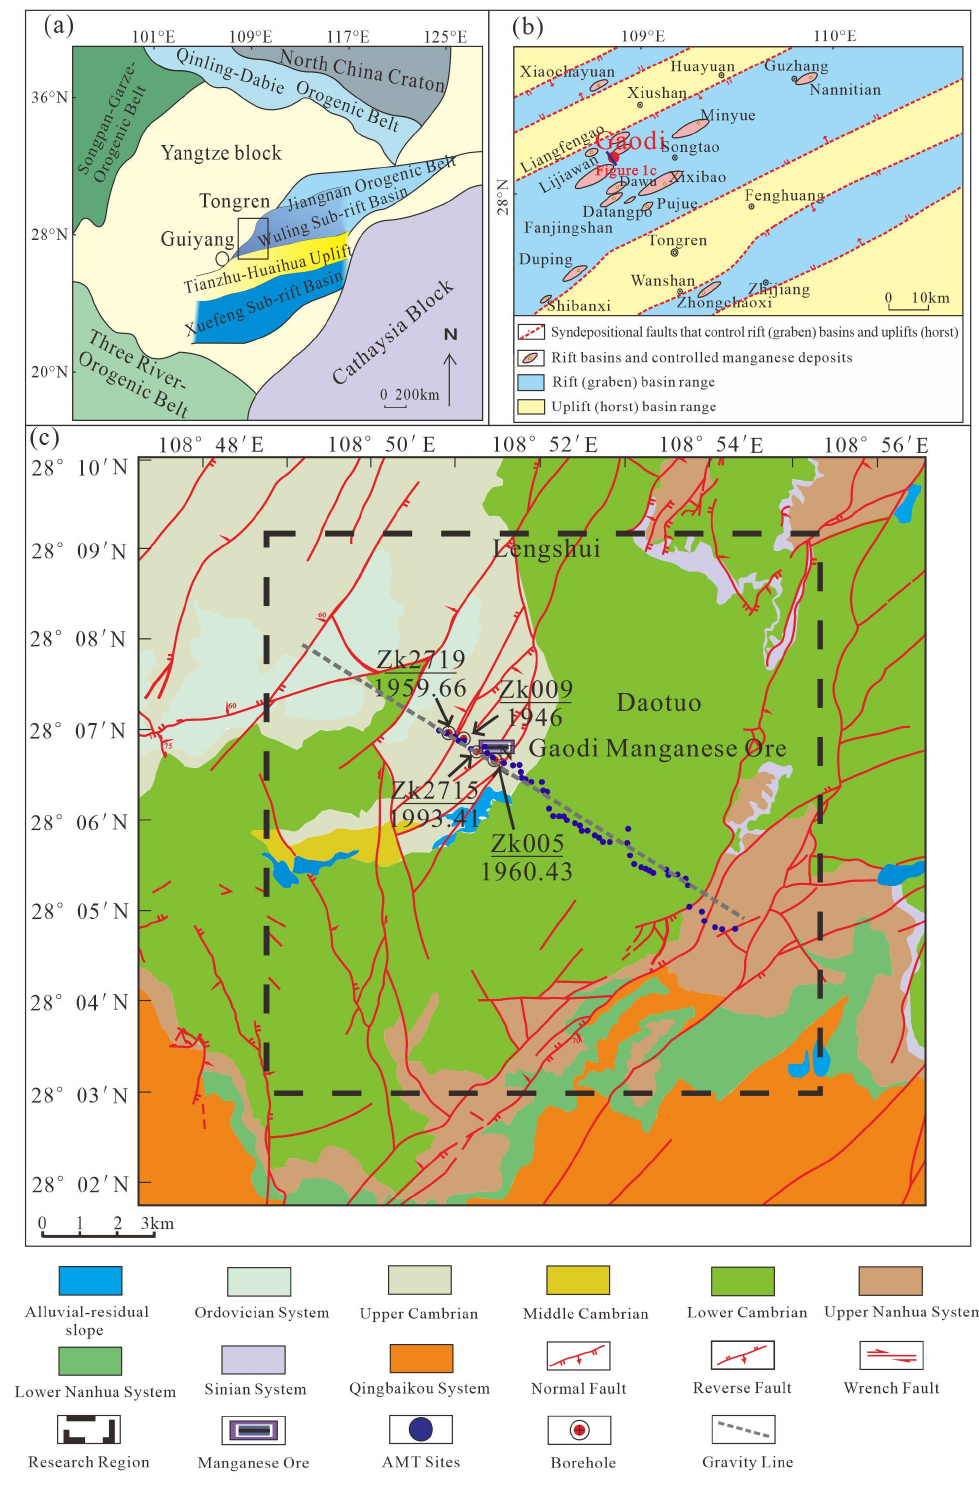
Figure 1. ( a ) Location and simplified geology map of the study area (redraw after [2]). The black boxes indicate the study area. ( b ) Subdivision of the Nanhua rift (modified after [13]). ( c ) Distribution map of the AMT stations and gravity stations. The black arrows point to the location of the boreholes.